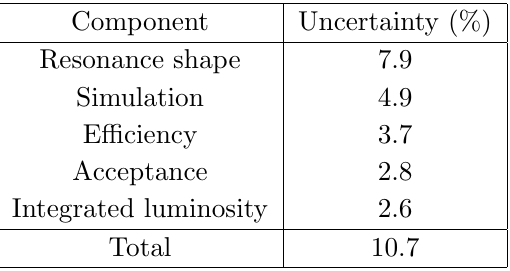
Table 1 . Summary of the relative systematic uncertainties in the (cid:7)(1S) pair production cross